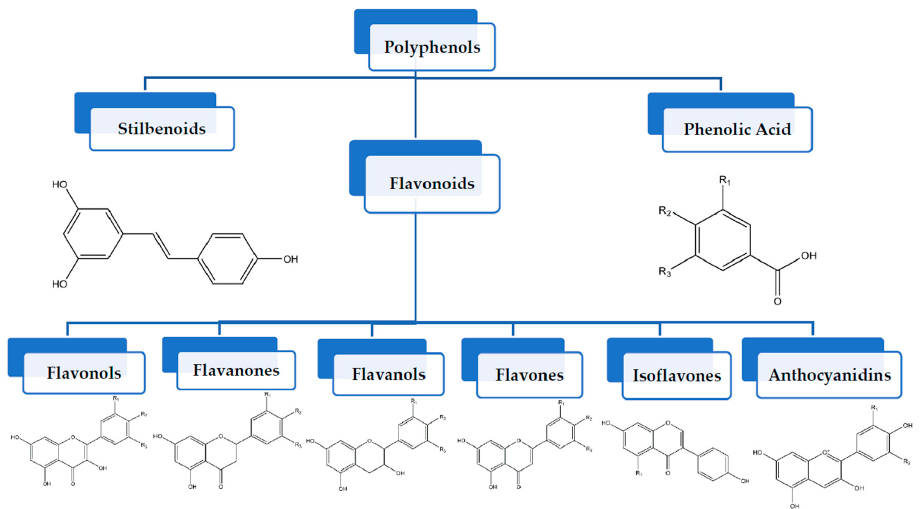
Figure 2. Different classification of polyphenols and their chemical structures. Flavonoids are subdivided into flavonols, flavanones, flavanols, flavones, isoflavones, and anthocyanidins.